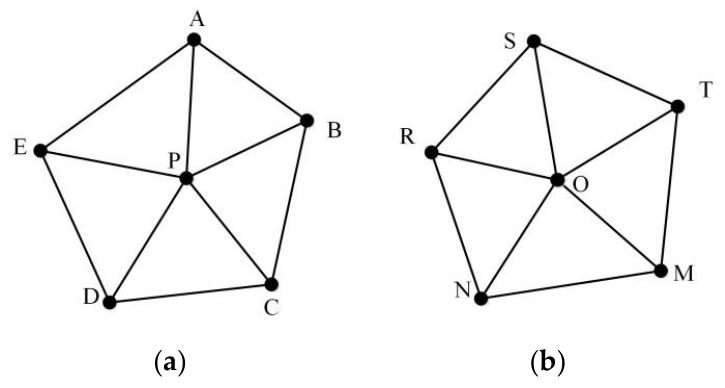
Figure 9. A pair of MMU s . ( a ) MMU P and ( b ) MMU O .